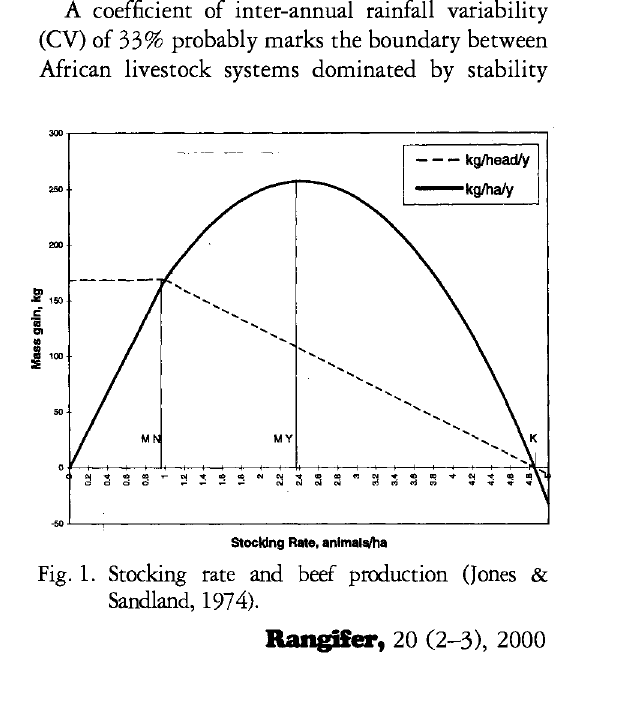
Fig. 1. Stocking rate and beef production (Jones & Sandland,